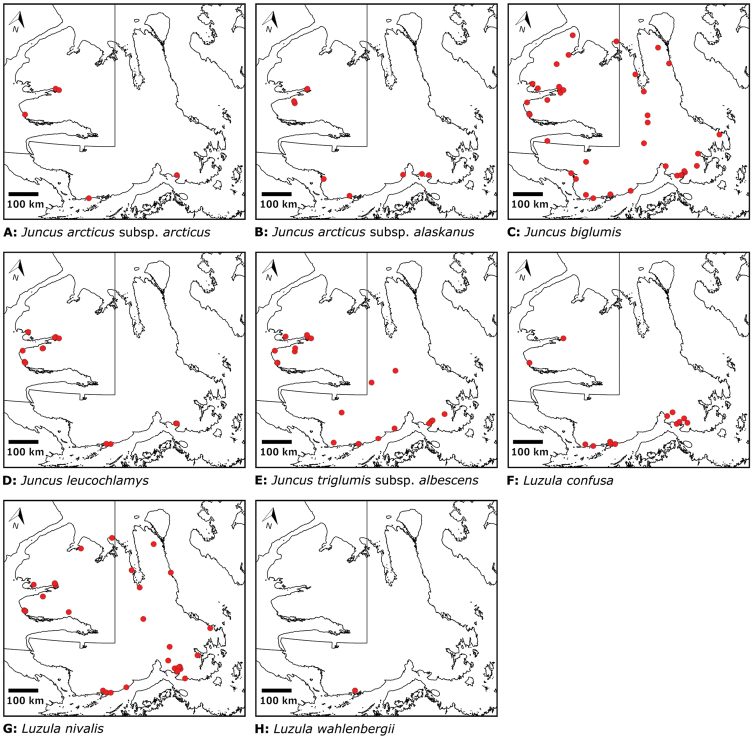
Species distribution maps. Juncaceae: AJuncus
arcticus
subsp.
arcticusBJuncus
arcticus
subsp.
alaskanusCJuncus
biglumisDJuncus
leucochlamysEJuncus
triglumis
subsp.
albescensFLuzula
confusaGLuzula
nivalisHLuzula
wahlenbergii.